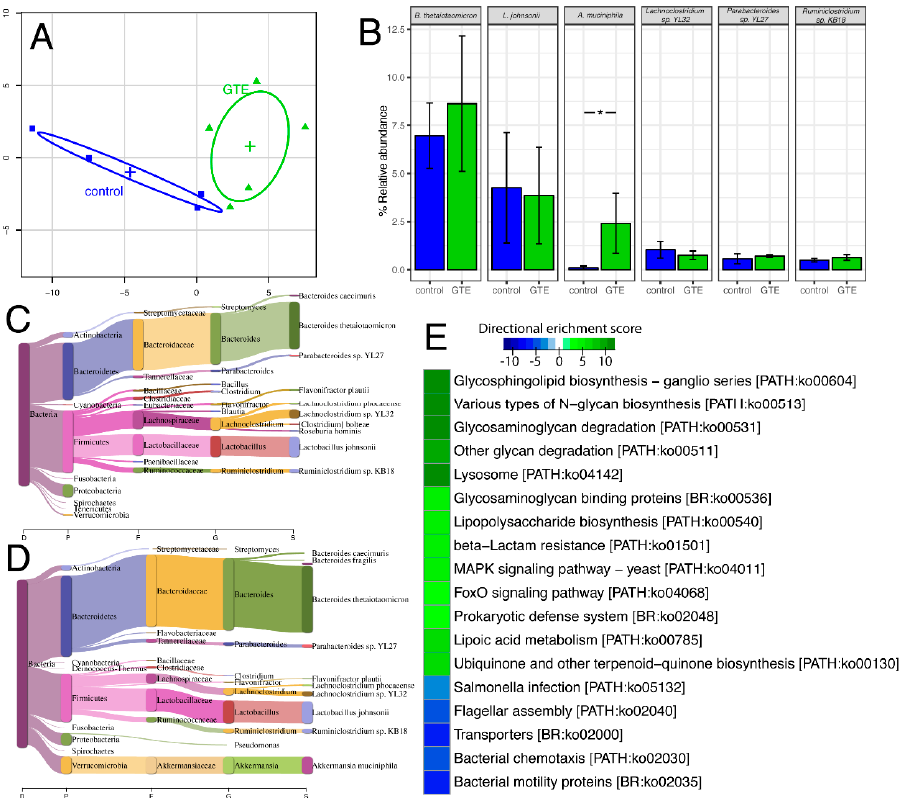
Figure 3. Shot gun metagenome analysis of dGTE (green) compare with control (blue). PCA plot of gut microbiome species abundance ( A ). Bag plots of high abundance gut bacteria (>5% relative abundance) in the study ( B ) * p < 0.05 compared to vehicle; mean +/ ‐ SEM ( n = 5 per group). Sankey diagram for visualization of species abundance in a taxonomic tree of a sample control group ( C ) and dGTE ( D ). Heat map of directional enrichment score ( − log10 enrichment p -value) for selected KEGG pathway ( E ).